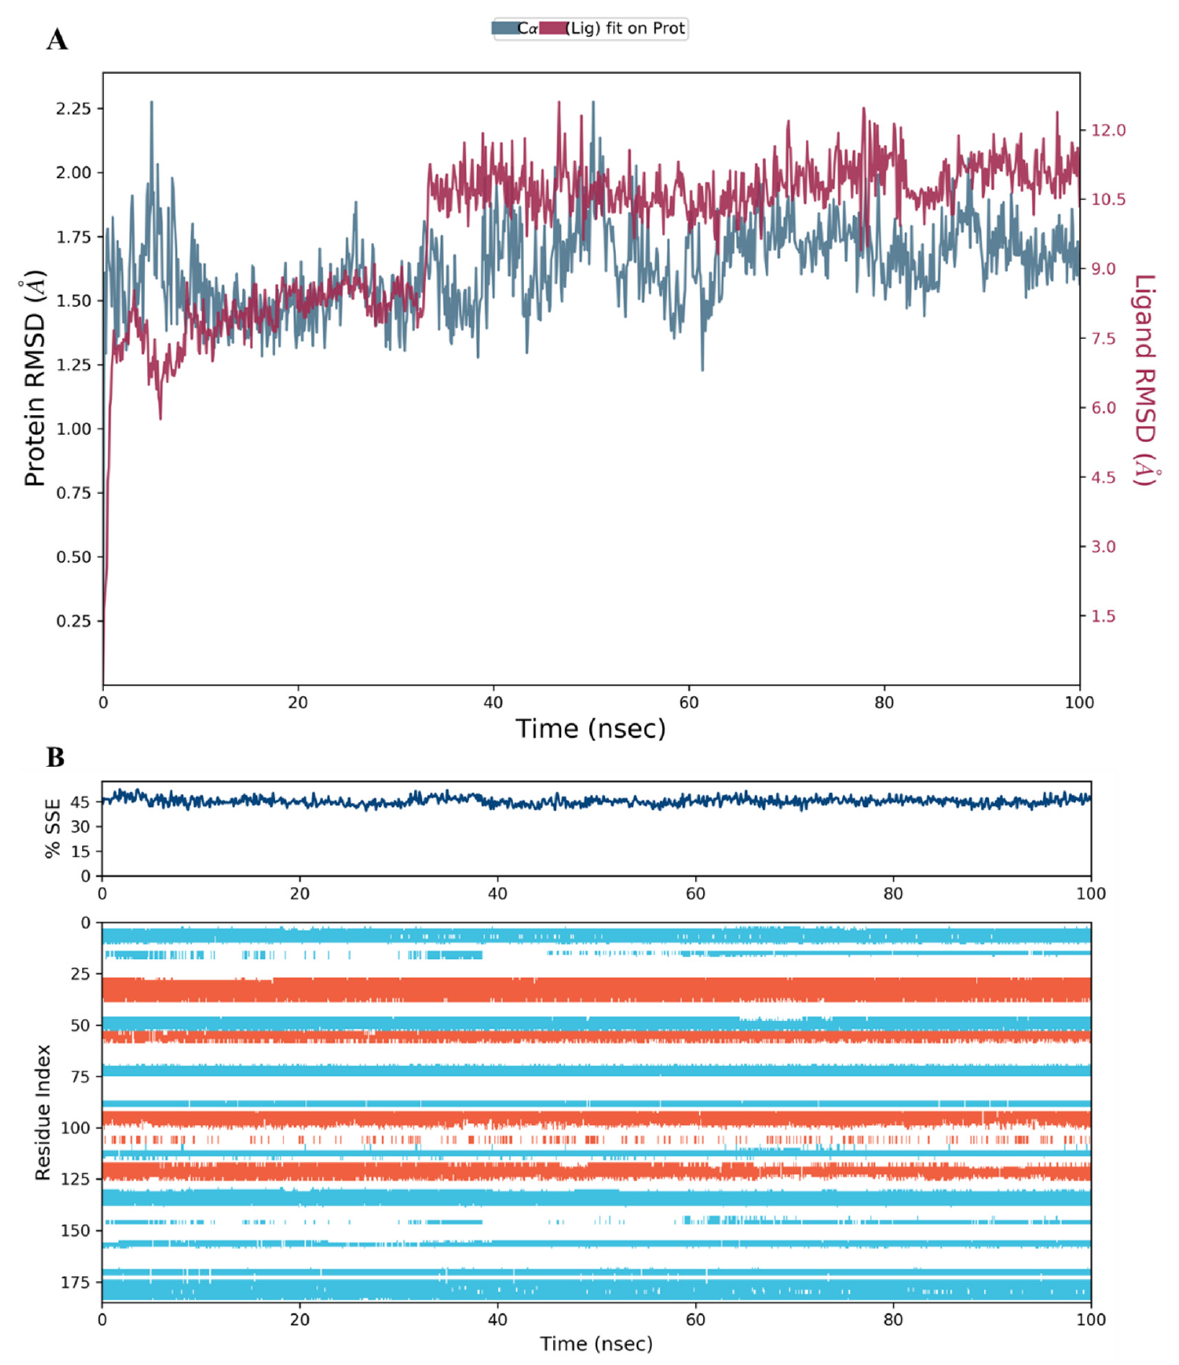
Figure 14. ( A ) The RMSD plot for compound 44 complexed with hDHFR (PDB: 1KMV) over a 100 ns simulation time; ( B ) Stability of the hDHFR secondary structure over 100 ns of MD simulation when complexed with 44 . Protein secondary structure elements (SSE) like alpha-helices (orange color) and beta-strands (light blue color) were monitored during the simulation. The upper plot reported SSE distribution by residue index across the protein structure, and the plot at the bottom monitored each residue and its SSE assignment over the simulation time.